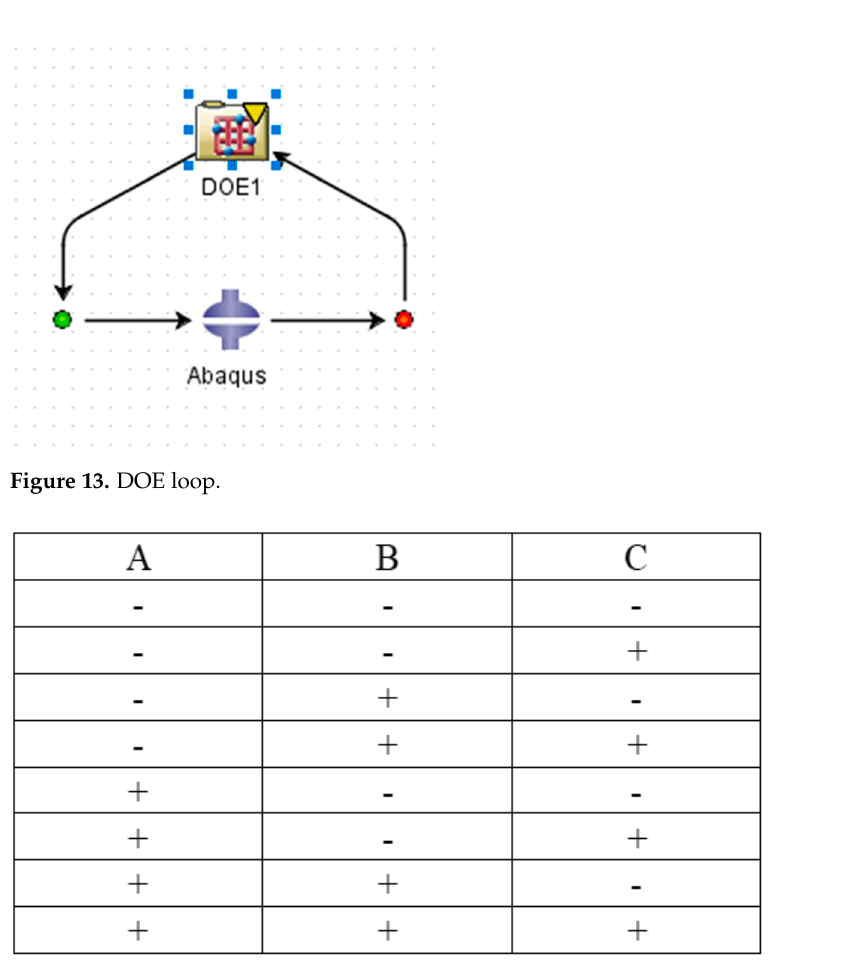
Figure 14. Full factorial two-level three-factor design matrix.